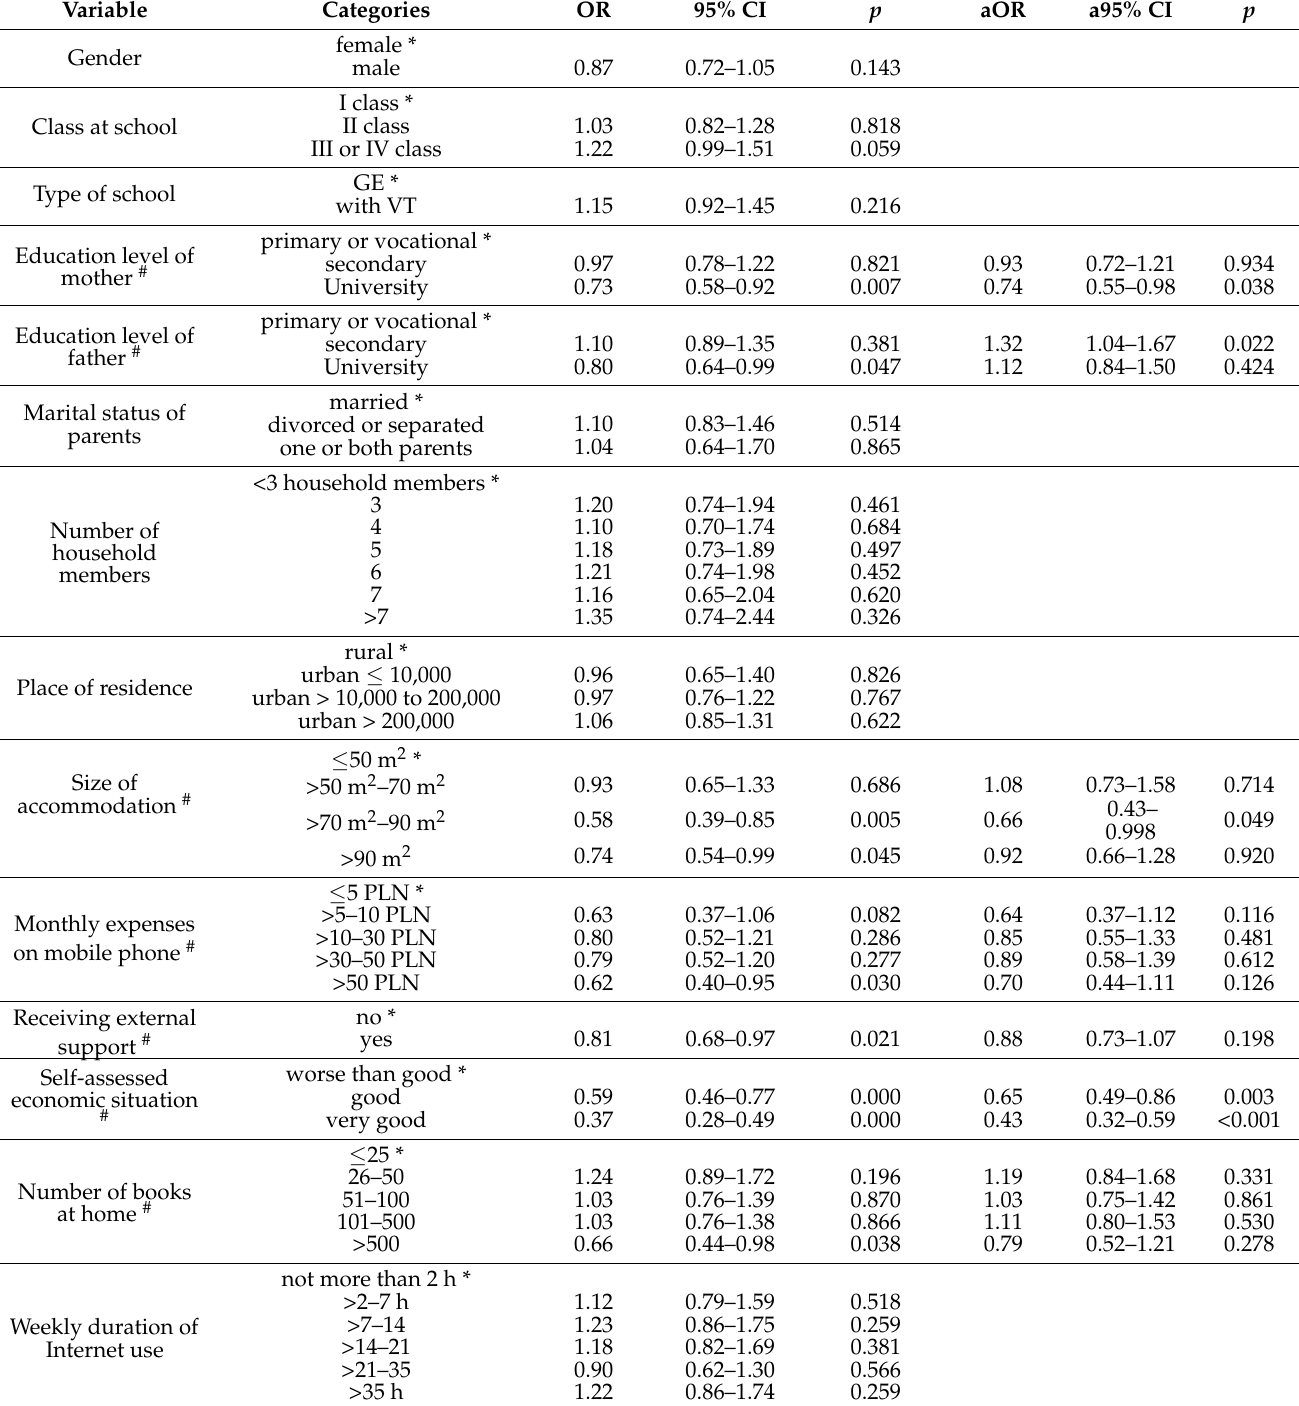
Table 3. Univariate and multivariate logistic regression models developed for the prevalence of limited